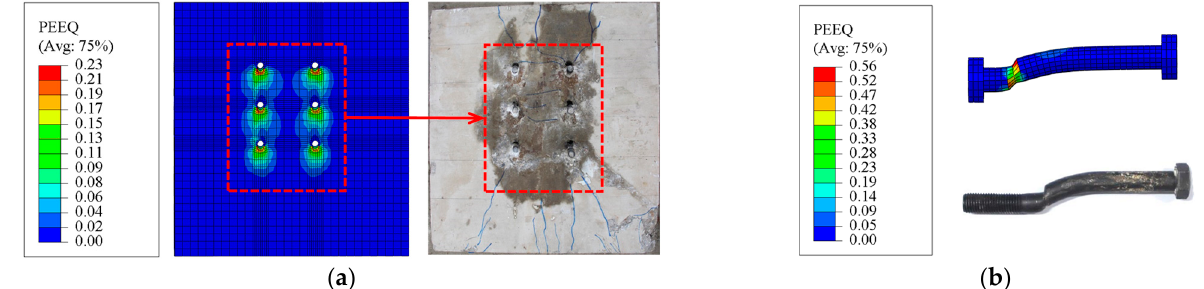
Figure 7. Comparison of the failure modes (e.g., TS4): ( a ) damage of the PC slab; ( b ) deformation of the bolt shear connector.